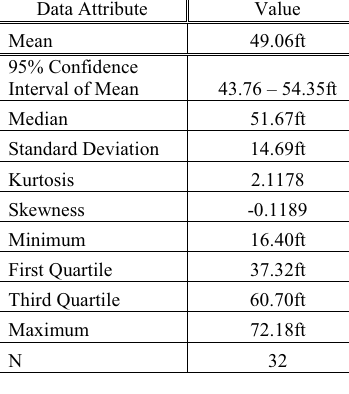
and distributions of thickness of Horizon